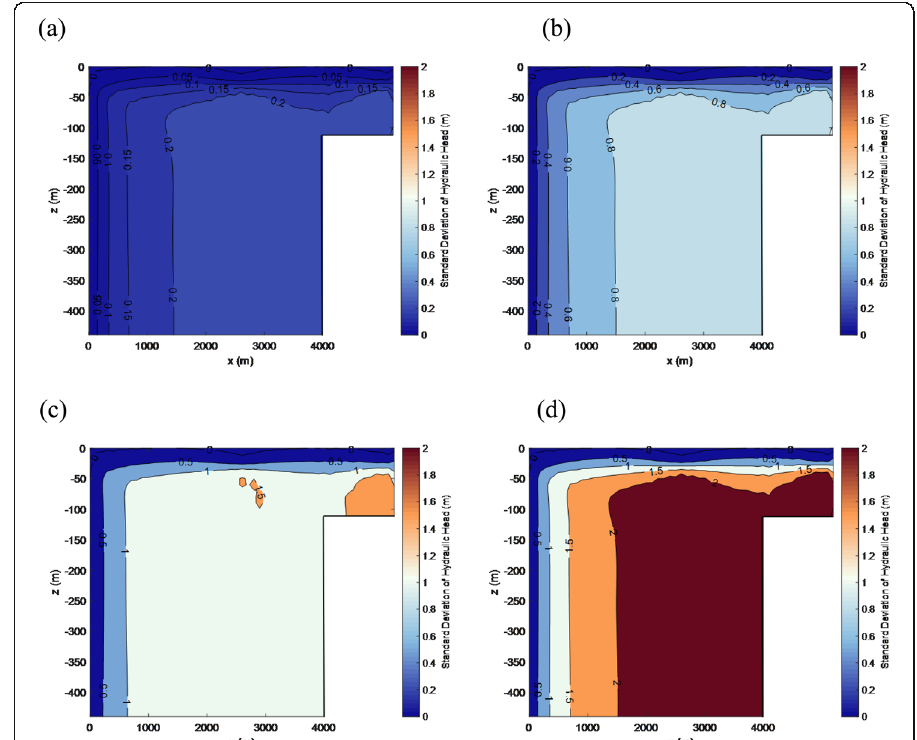
Fig. 13 Uncertainty of hydraulic head over the years considering the spatial variability of k a ( l x = 200 m, l z = 40 m, COV = 0.3). a Year 1. b Year 4. c Year 7. d Year